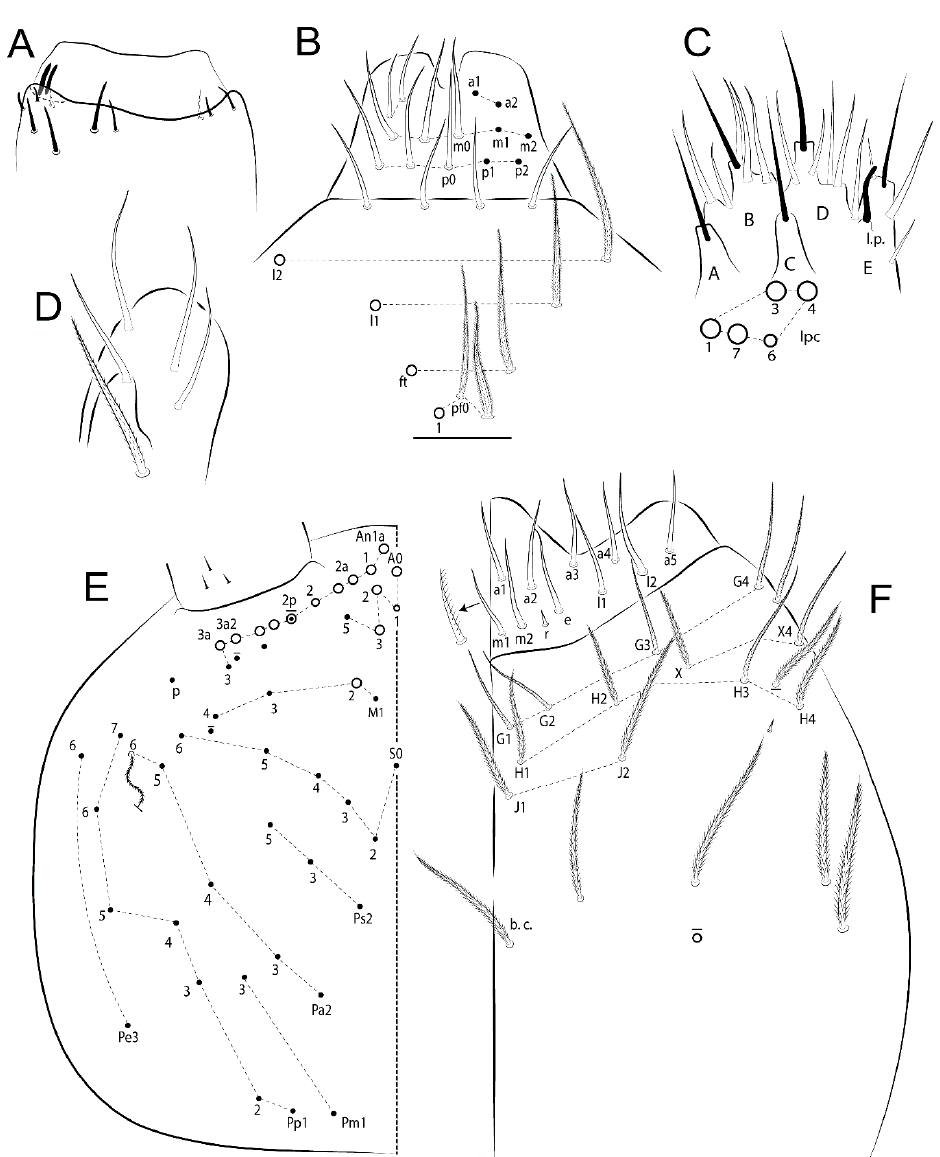
Figure 37. Pseudosinella alfanjeunguiculata sp. nov.: head. ( A ) Ant III apical organ (ventro-lateral view); ( B ) chaetotaxy of clypeus, prelabrum and labrum; ( C ) labial papillae (H omitted) plus proximal chaetae; ( D ) maxillary palp and sublobal plate (left side), minute appendage omitted; ( E ) head dorsal chaetotaxy (left side); ( F ) basomedian and basolateral labial fields and complete postlabial chaetotaxy (right side).